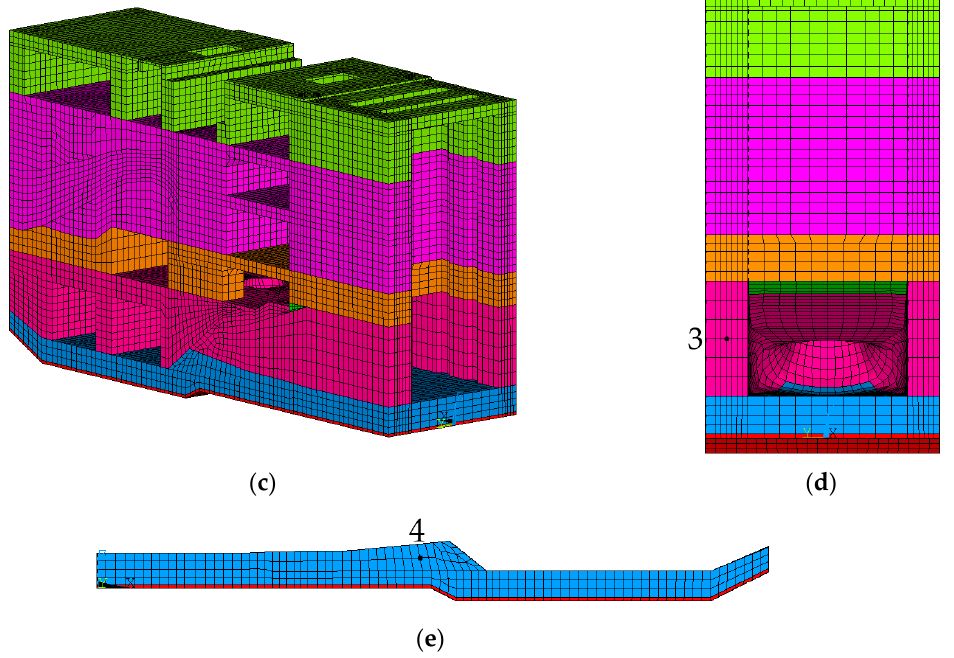
Figure 9. Finite element model and feature point location of the outlet section of Lianghu pump station. ( a ) The whole model; ( b ) elements of the pile; ( c ) elements of drainage structure; ( d ) feature point 3; ( e ) feature point 4.